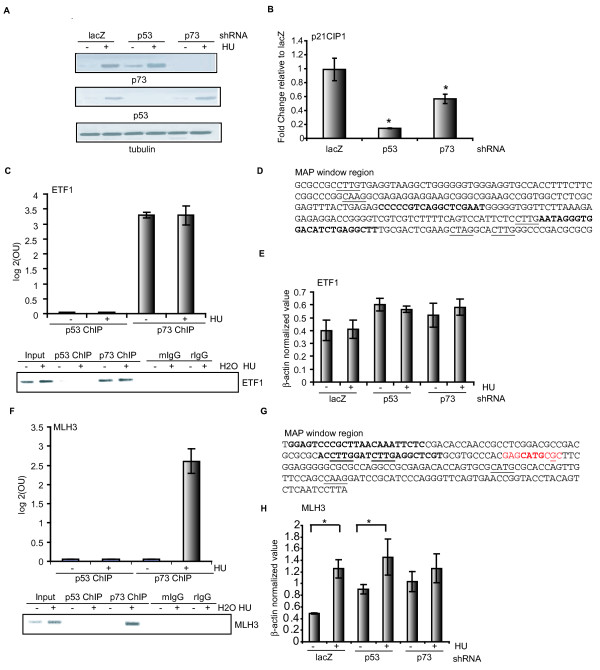
MLH3 is a p73-specific target induced by hydroxyurea. (a) Western blotting analysis of lysates from untreated or hydroxyurea (HU)-treated HCT116-3(6) cells (1 mM, 16 hours) stably expressing lacZ, p53, or p73 small hairpin RNA (shRNA). (b) Effect of p53 or p73 knockdown on p21cip1 gene expression. Real-time RT-PCR analysis of the steady-state p21cip1 mRNA level in HCT116-3(6) cells stably expressing p53 or p73 shRNA *P < 0.05, n = 3 (c) Chromatin from untreated or HU-treated HCT116-3(6) cells (1 mM, 16 hours) were immunoprecipitated with the indicated antibodies and followed by PCR analysis using the primers flanking the ETF1 promoter region defined by the model-based algorithm for promoter array (MAP) promoter-score. Data are represented as log2 occupancy units from two independent ChIP experiments +/- standard deviation. Enrichment was confirmed by agarose gel electrophoresis analysis (bottom). (d) MAP window sequence. Primers used for qChIP analysis in (c) are indicated in bold. The core consensus sequence of p53 is underlined. (e) ETF1 mRNA level in the stable cell lines described in (a) with or without HU treatment was examined by RT-PCR analysis. (f) qChIP analysis of the MLH3 promoter was performed as in (c). (g) MAP window sequence. Primers used for qChIP analysis in (f) are shown in bold. The core consensus sequence of p53 is underlined. The p53 half site is highlighted in red and underline indicates mismatches. (h) Effect of p53 or p73 knockdown on MLH3 gene expression. Same analysis was carried out as in (e). *P < 0.05, n = 3.